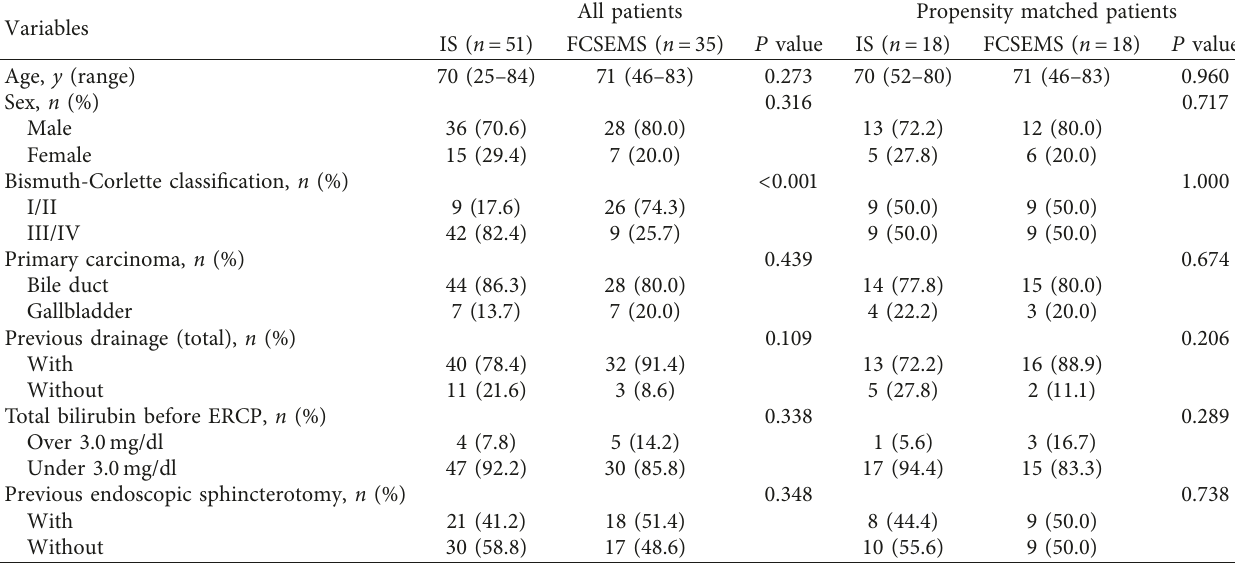
Table 1: Clinical characteristics according to the type of